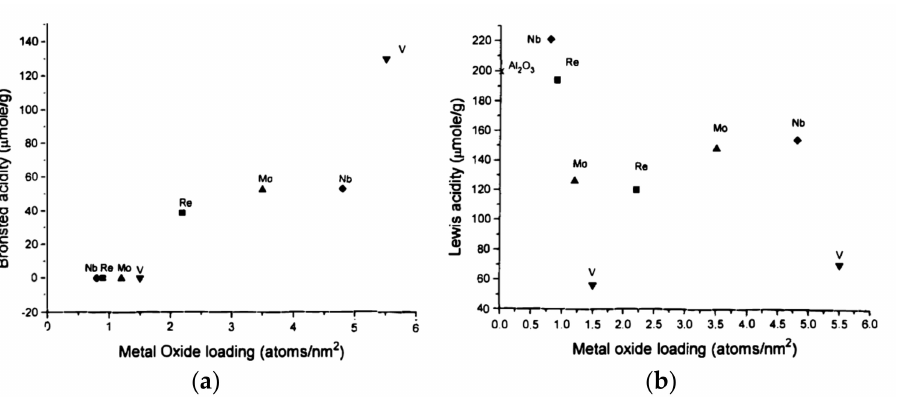
Figure 7. Dependence of ( a ) Brønsted and ( b ) Lewis acidity on metal loading on Al 2 O 3 support. Reprinted from [49] Copyright © (1996) with permission from